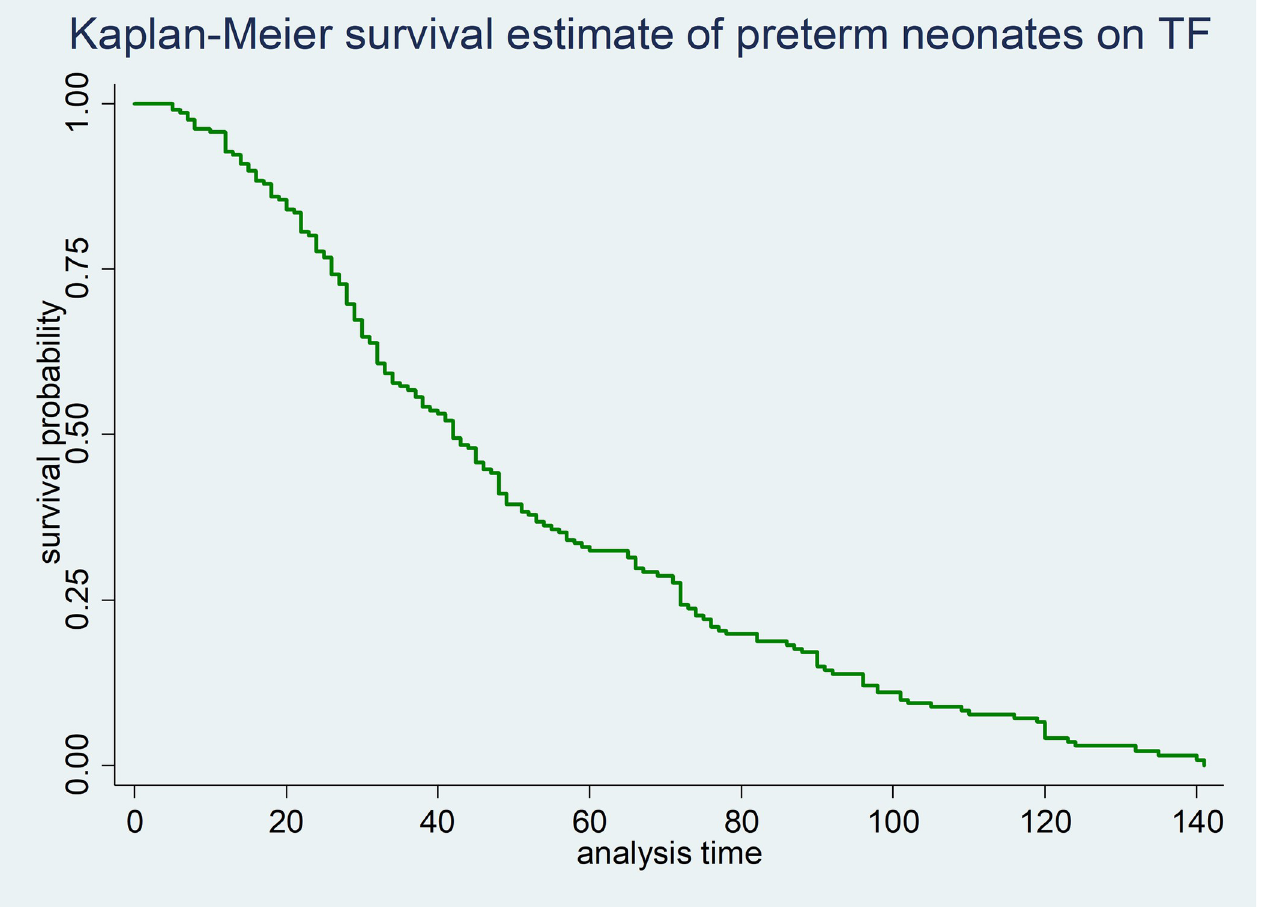
Fig 1. The Kaplan-Meier survival estimates of time to initiate TF among neonates admitted to NICU of DMCSH, FHCSH, and TGCSH, Amhara, Northwest Ethiopia from October to November/2020 (n = 210).